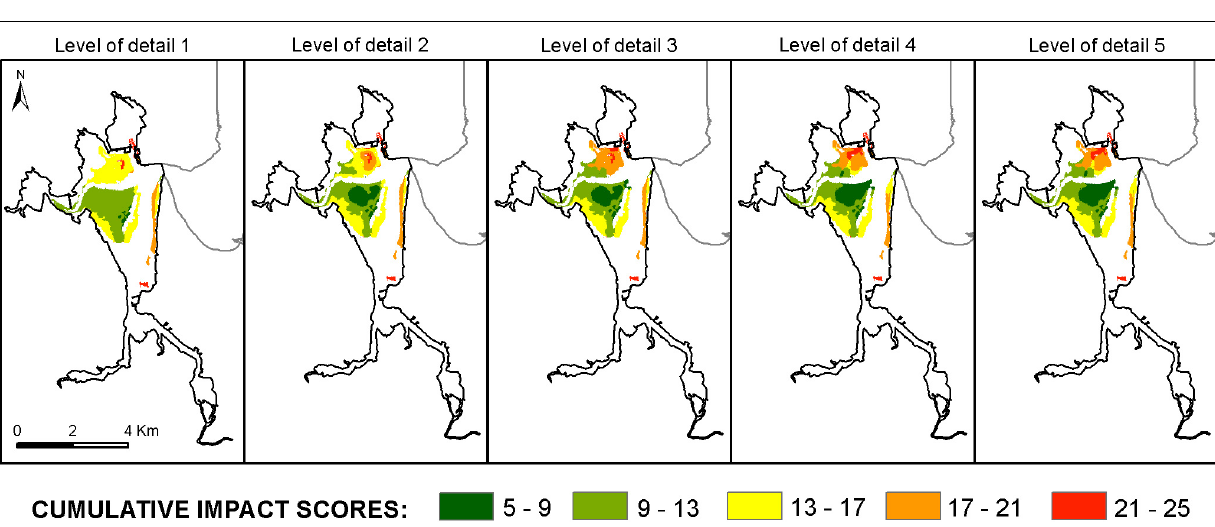
FIGURE 6 | Cumulative impact scores, for all the pressure types used in this analysis, per spatially independent unit of the ecotope map of Zostera noltei at five spatial